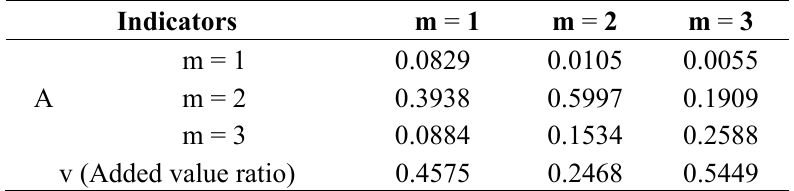
Table 3. Input-output coefficient between three industries for Tianjin city in